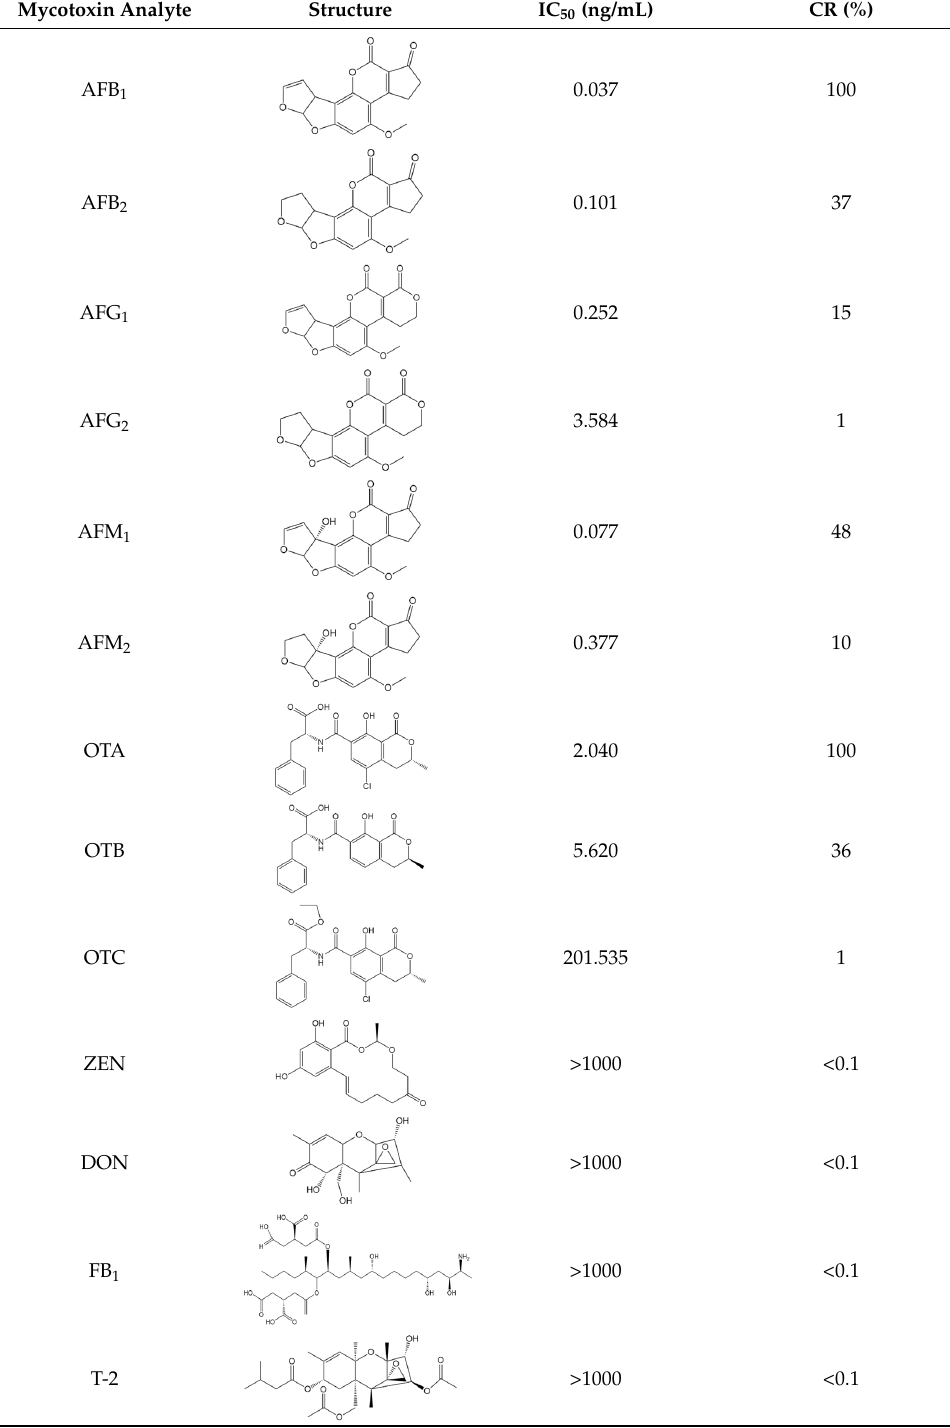
Figure 4. The electropherogram of BsMAb: ( a ) ascites; ( b ) purified BsMAb. The cross-reactivity of the BsMAb with other common mycotoxins was detected by ELISA. As shown in Table 2, five mycotoxins containing similar structures displayed evi- dent cross-reactivities. The cross-reaction rate with AFB 2 was 37%, with AFG 1 15%, with AFM 1 48%, with AFM 2 10%, and with OTB 36%. Negligible cross-reaction was observed with other tested compounds. Table 2. IC 50 and cross-reactivity (CR) of anti-AFB 1 /OTA BsMAb against related mycotoxins. Mycotoxin Analyte